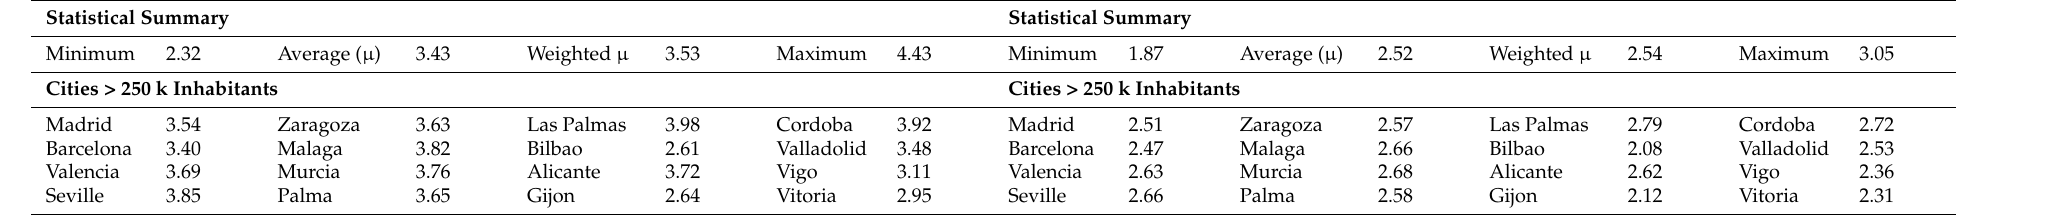
Figure A1. Production in MWh/year (PV left , ST right ). Table A1. Production in MWh/year (PV left , ST right